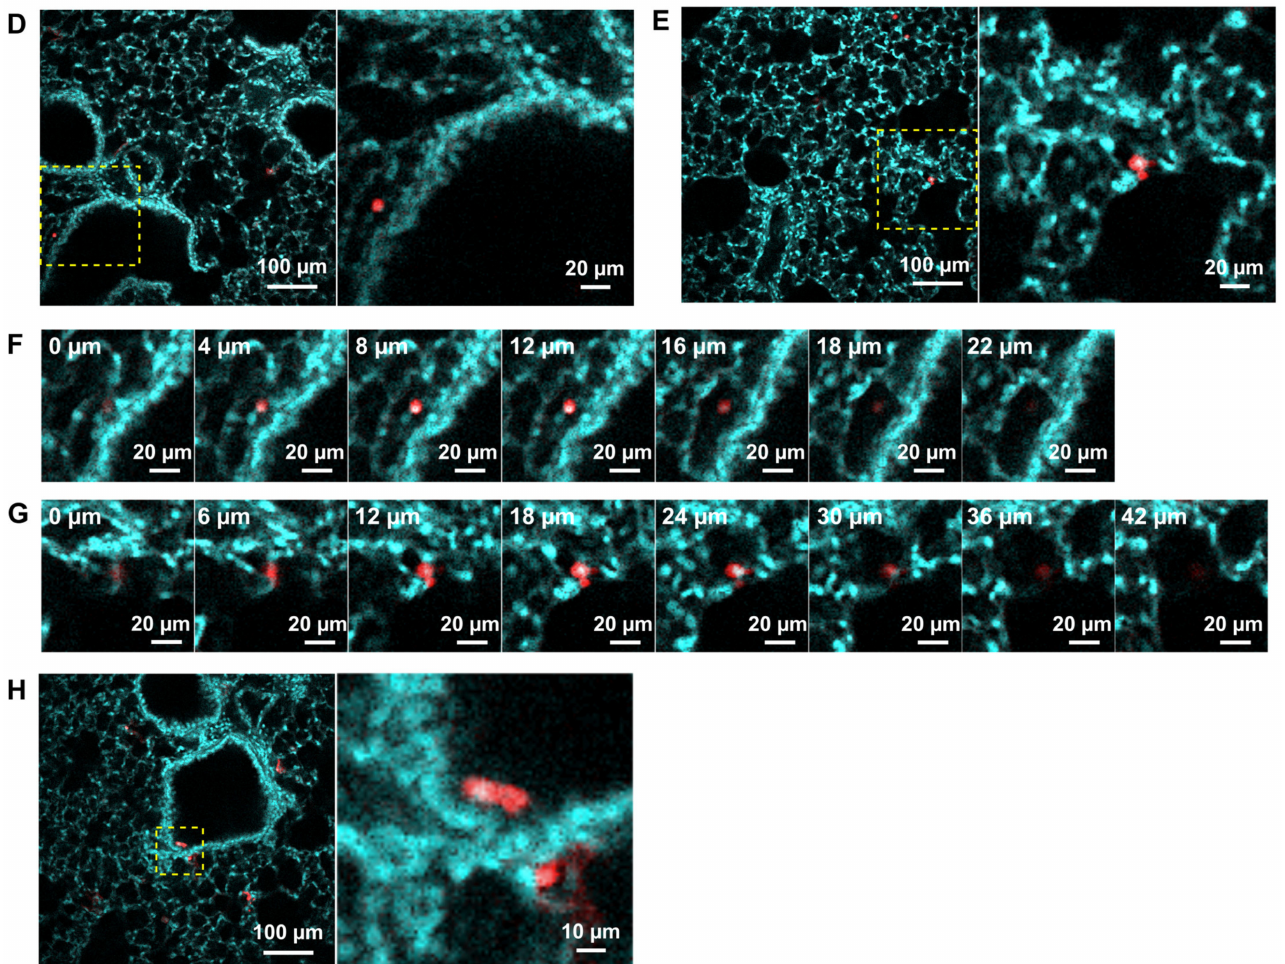
Figure 3. Identification of RSV infected cells in lung biopsies. rHRSV-mCherry infected mouse lung biopsies at 4 d.p.i. were treated with DAPI (cyan) and anti-mCherry antibody (red) to detect cells nuclei and RSV infected cells, respectively. Immunostained biopsies were acquired by 2-photon microscopy post clearing. ( A ) 3D rendering of 3D acquisitions showing a desquamated infected cell in the lumen of the airway (yellow arrow) and a macrophage in the alveolar lumen (white arrow). Optical sections of representative 2-photon acquisitions showing mCherry + epithelial cell ( B ), type I pneumocytes ( C ), alveolar macrophage ( D ) and type II pneumocyte infected by RSV ( E ). Yellow dotted squares delineate the region presented in a magnified view in the bottom panel. Selection of successive optical sections showing an alveolar macrophage ( F ) localized in the alveolar lumen and a type II pneumocyte ( G ) lining the alveoli wall. Depth is indicated in the upper-left corner of each image. Optical section showing a desquamated infected cell in the lumen of the airway ( H